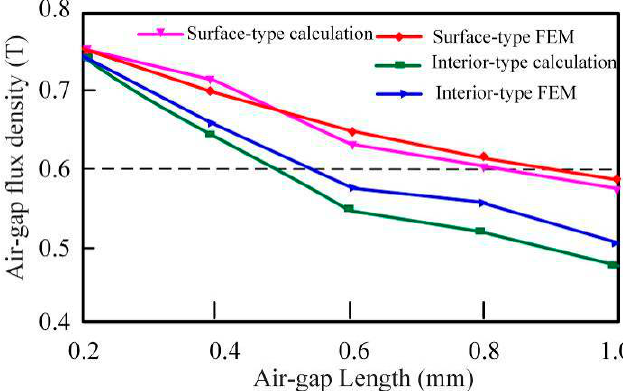
Figure 3. Air-gap flux density of surface-type and interior-type rotor.